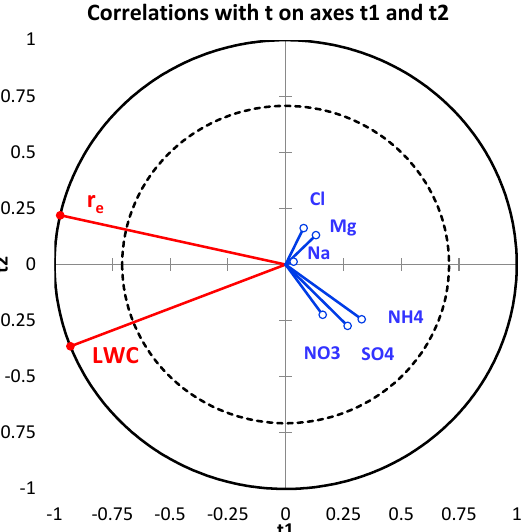
Figure 8. Chemistry / Microphysics PLS chart of cloud samples with t component on axes t1 and t2. Correlations map allows superimposing the “Xs” and the “Ys” (observations are removed for clarity). PLS performed on 73 cloud events. The dependent variables from the chemical matrix are displayed in blue, the explanatory variables from the microphysics matrix in red.